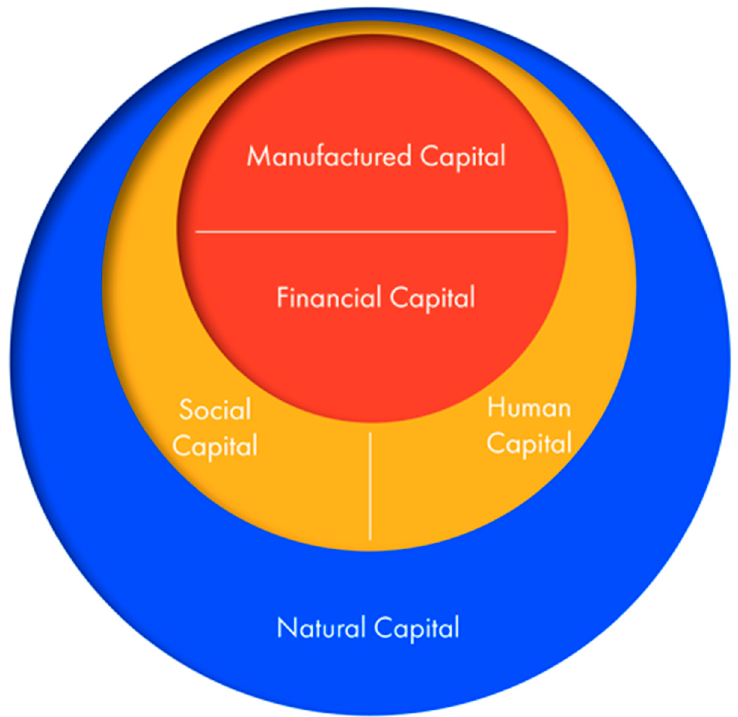
Figure 6. The Five Capitals model. Source: The Forum for the Future. The Five Capitals Model. Available online: https://www.forumforthefuture.org/the-five-capitals.